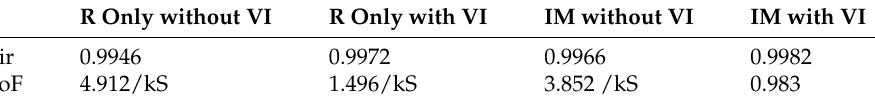
Table 4. Frequency comparison in different cases of HPF controller.